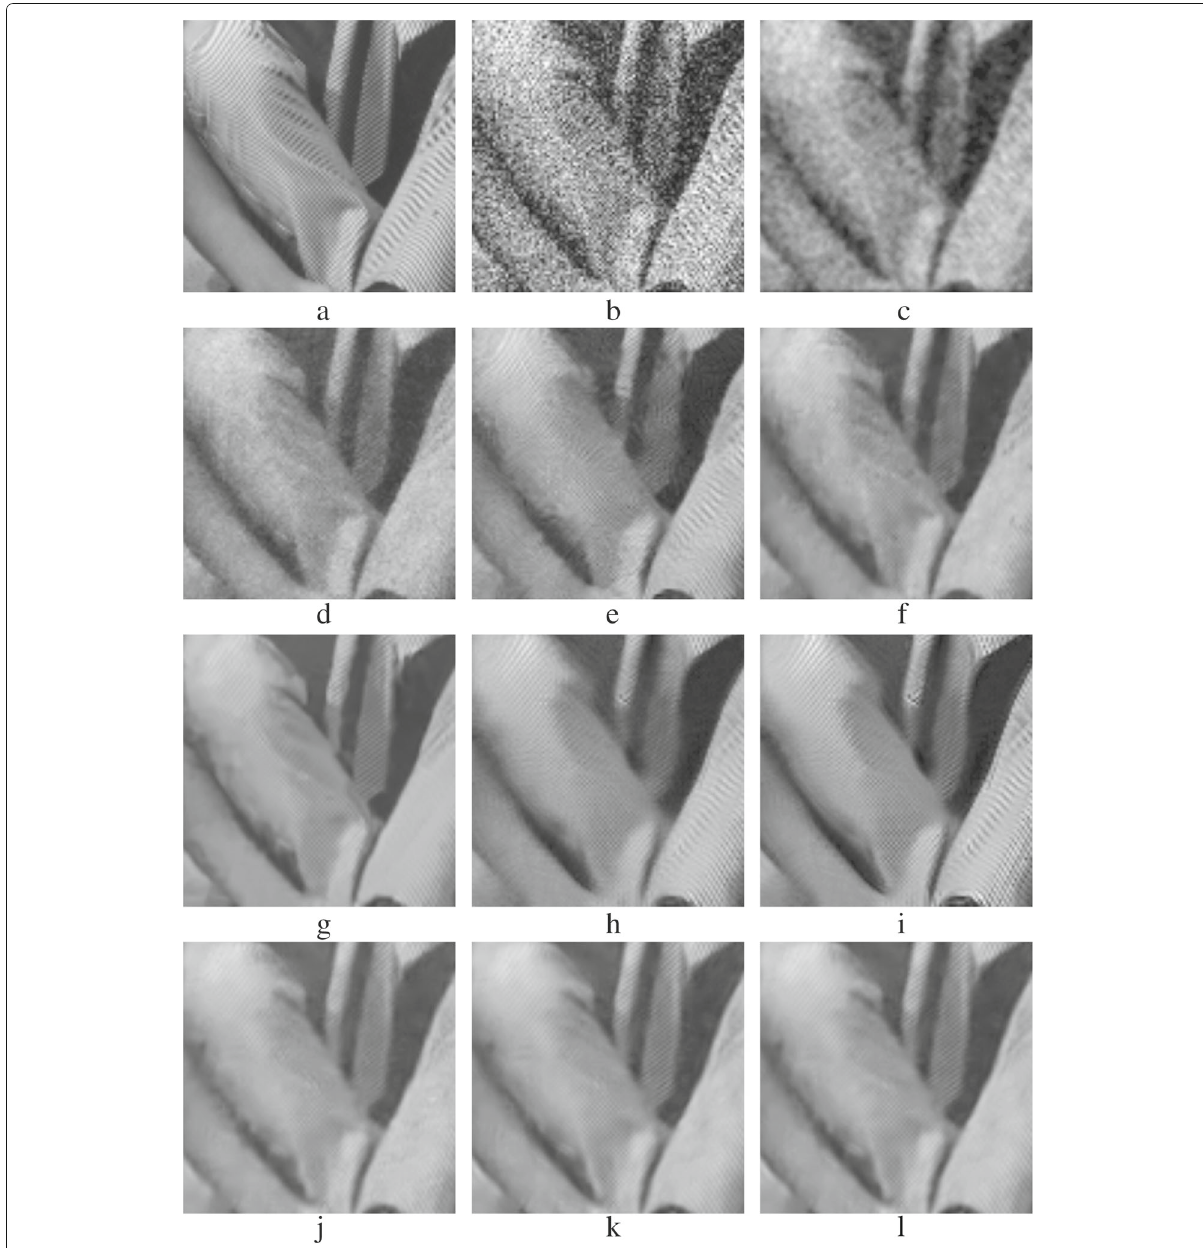
Fig. 16 Zoomed images of the denoised Barbara image shown in Fig. 15: a original Barbara’s pant; b AWG noise, σ = 40; c AD (Perona & Malik); d bilateral filtering; e NL-Means filtering; f K-SVD; g BM3D; h Non-itPPB; i It-PPB; j PGPCA; k PLPCA; and l PHPCA